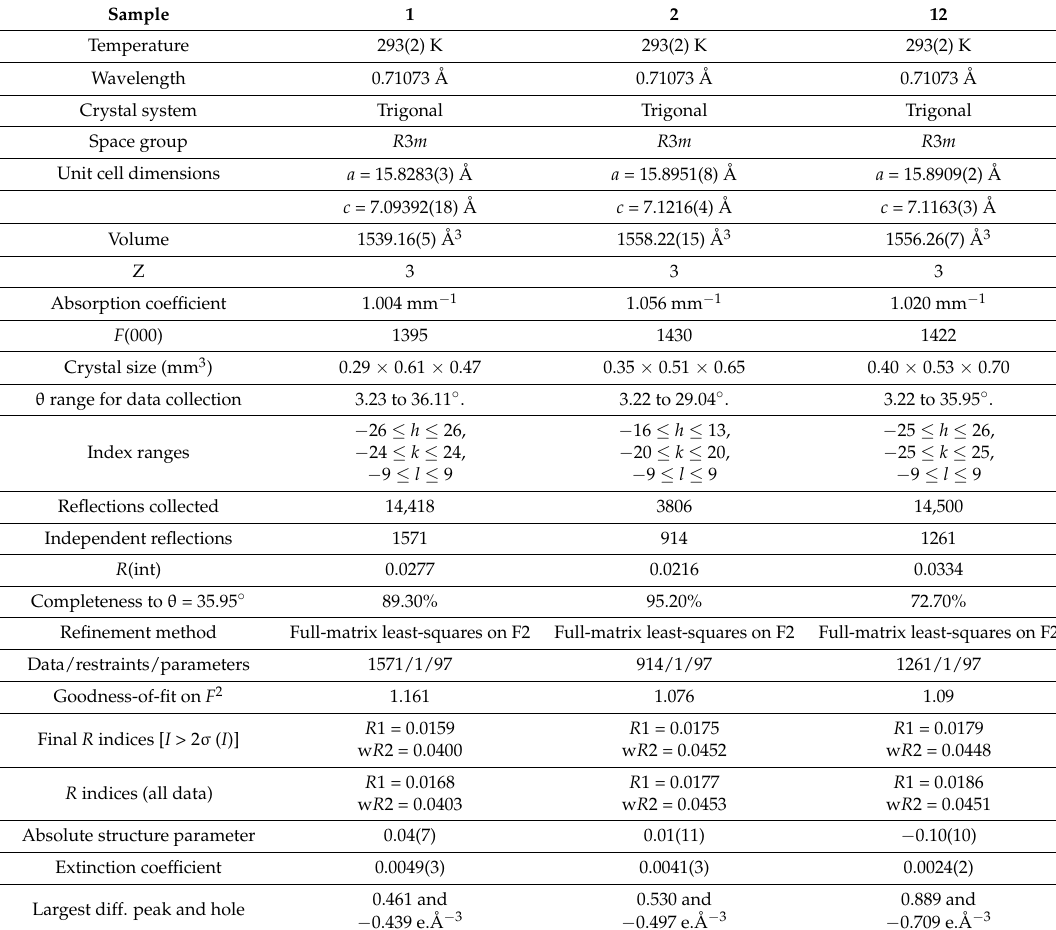
Table 4. Crystal data and structure refinement for tourmalines 1, 2,